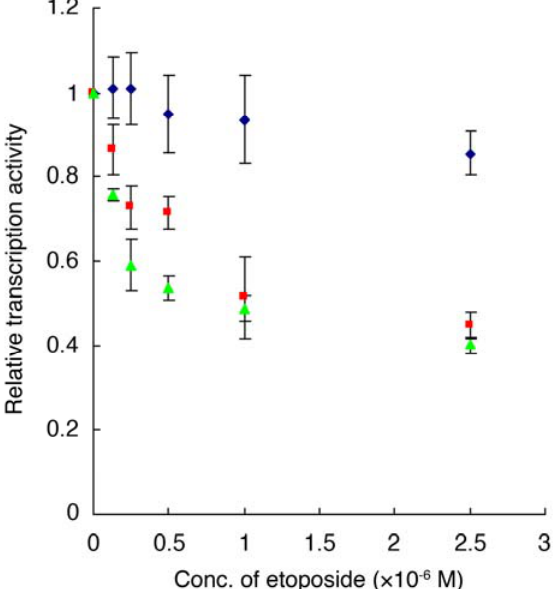
Figure 9. Relative luminescence in the presence or absence of etoposide. ■ , E2F4/DP1 expressing cell, ▲ , E2F-4/DP2 expressing cell, ◆ , control cell transfected with vehicle. Data are means ± S.D. of three independent